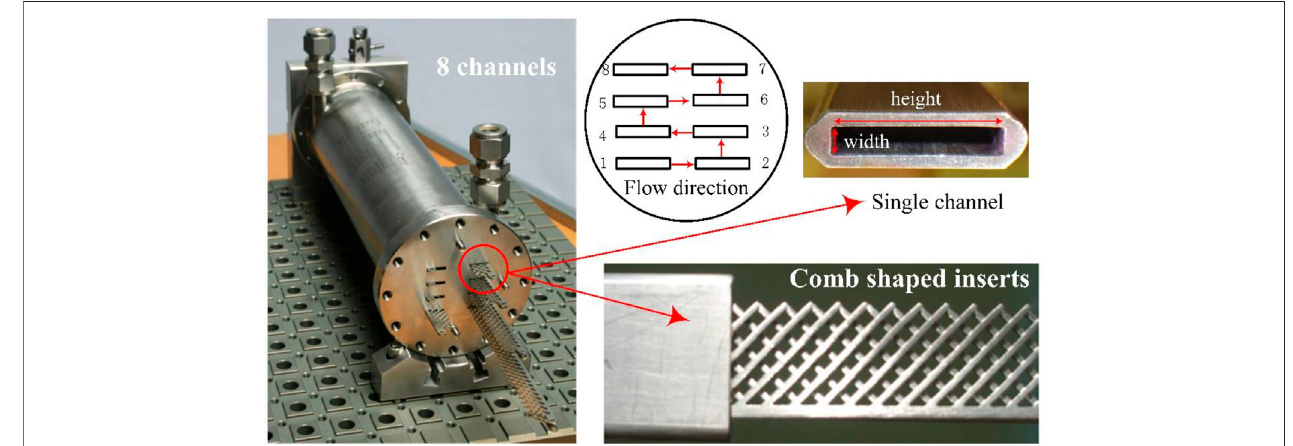
FIGURE 1 | Photo of a commercial microreactor with detailed inset structures.